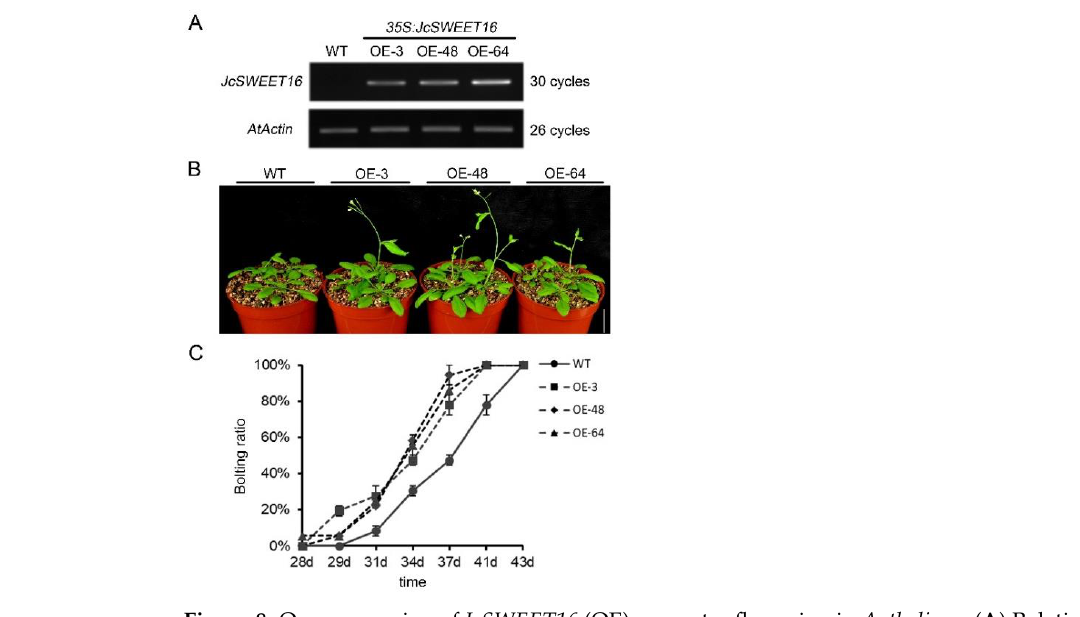
Figure 8. Overexpression of JcSWEET16 (OE) promotes flowering in A. thaliana . ( A ) Relative expres- sion levels of JcSWEET16 in different transgenic lines measured using semi-quantitative RT-PCR analysis. ( B ) WT plants and OE lines grown for 34 d. ( C ) Flowering time of WT plants and OE lines. At least 18 plants were used for each experiment. Scale bar = 2 cm. To gain insight into the function of JcSWEET16 in response to salinity stress, the same three OE lines were used for salinity treatment. No differences were detected between WT and transgenic lines on a normal 1/2 MS medium, whereas the survival rate of the OE lines was significantly higher than those of WT seedlings when cultivated with 150 mM NaCl (Figure 9). However, there were no significant differences in seedling root length or chlorophyll content between WT and transgenic lines when cultivated with 300 mM Mannitol (Figure S5). These results suggest that the overexpression of JcSWEET16 in A. thaliana could improve saline tolerance.